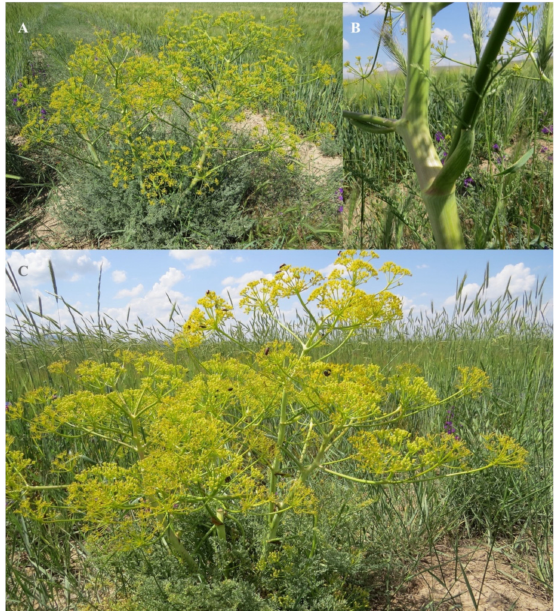
Figure 3. ( A , C ) General view of Ferula latialata . ( B ) Sheath.